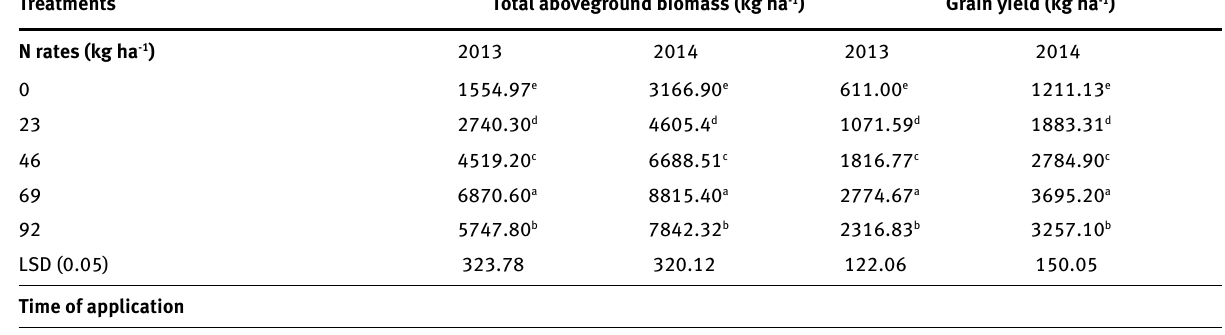
Table 1: Effect of N rate, timing of application and variety on biological yield and grain yield of bread wheat in Enderta district, Tigray Treatments Total aboveground biomass (kg ha -1 ) Grain yield (kg ha -1 ) N rates (kg ha -1